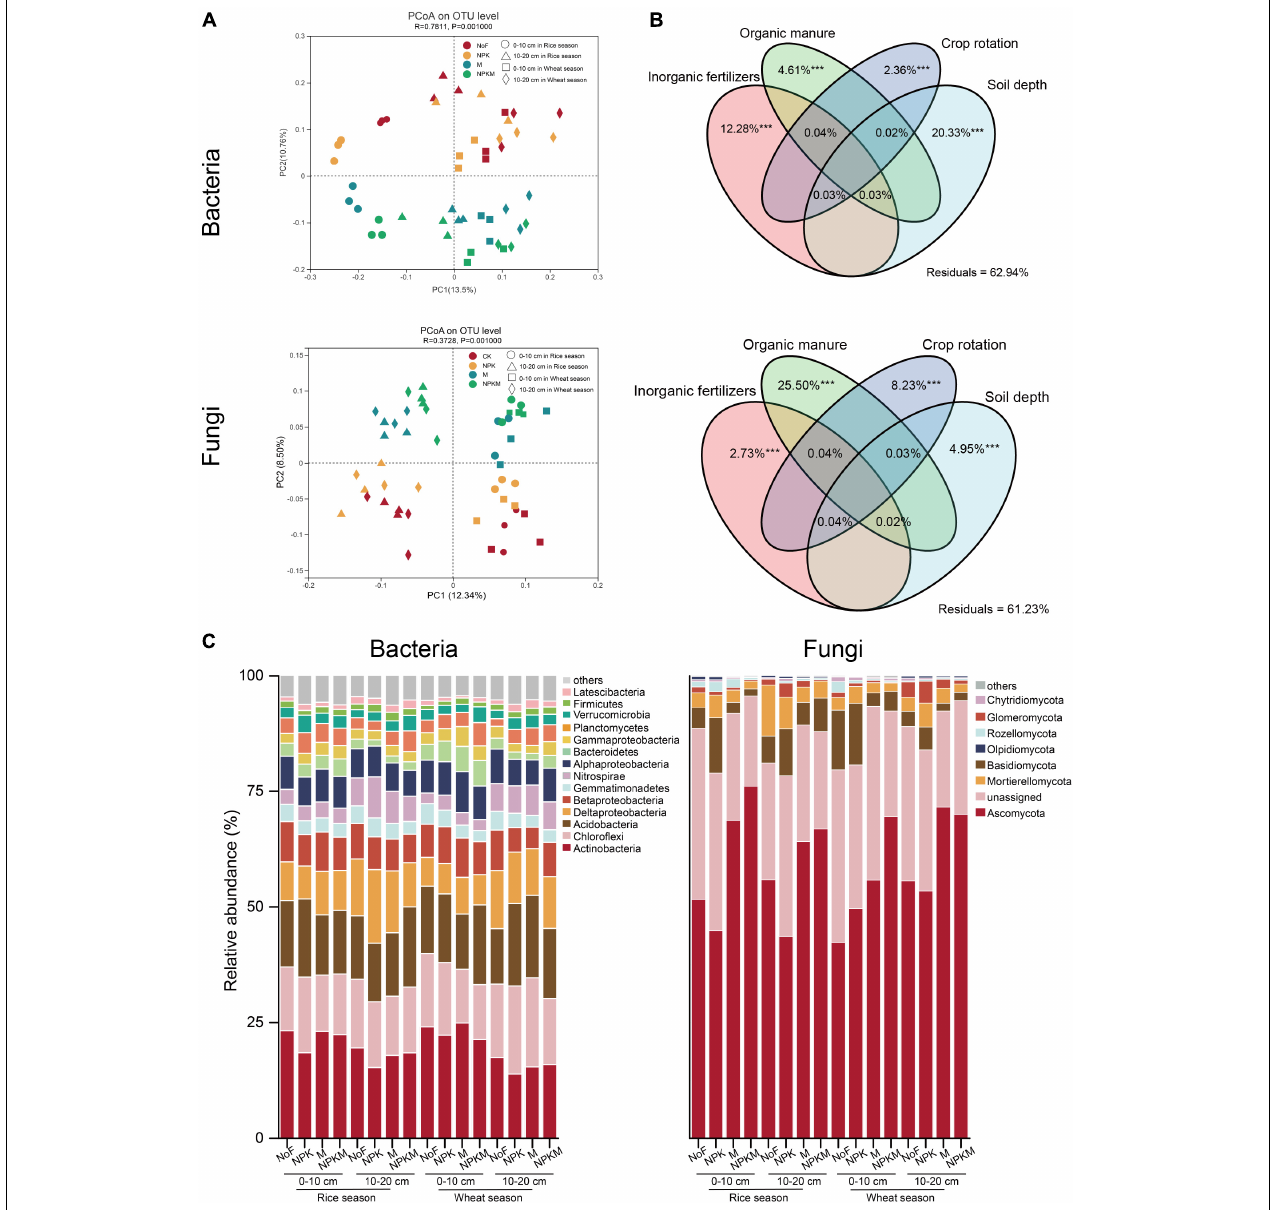
FIGURE 1 | Soil bacterial and fungal community compositions. (A) PCoA analysis of soil bacterial (upper) and fungal (lower) community compositions. (B) Variance partitioning analysis (VPA) of the bacterial (upper) and fungal (lower) communities by inorganic fertilization, organic manure, crop rotation, and soil depth. Values < 0 were not shown. *** indicated significance at p < 0.001. (C) Taxonomic profiles of bacterial and fungal communities at phylum level. Bacteria and fungi phyla with relative abundances lower than 1% were summarized with “others”